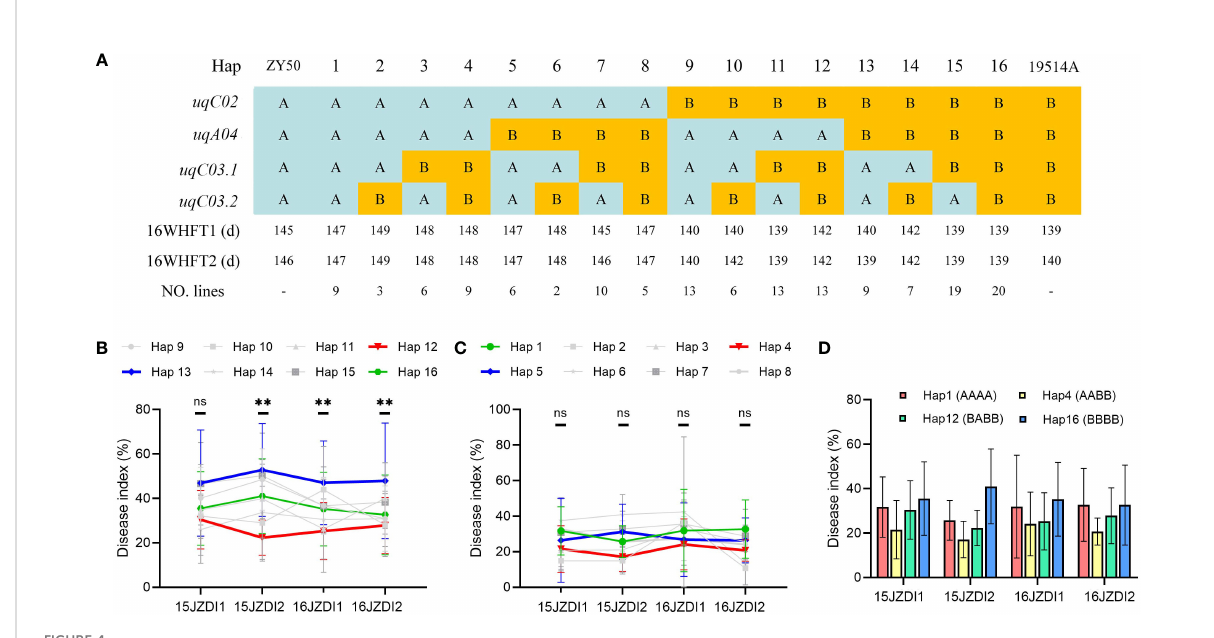
FIGURE 4 Haplotype analysis in the double haploid (DH) population. (A) DH population was divided into 16 haplotypes based on the genotypes of the four quantitative trait loci (QTLs). The number of lines per haplotype and average fl owering time (FT) are shown. (B) Mean value of disease index (DI) and order of haplotypes 9 – 16 in four replicates. Data are shown as the mean ± SD. Differences between haplotype 12 and haplotype 13 were analyzed for signi fi cance; ns indicates no signi fi cant difference, **P < 0.01 (one-way analysis of variance). (C) Mean value of DI and order of haplotypes 1 – 8 in four replicates, with the data shown as the mean ± SD. Differences between haplotype 4 and haplotype 5 were analyzed for signi fi cance; ns indicates no signi fi cant difference (one-way analysis of variance). (D) DI values of haplotype 4 were less than those of haplotype 1 in all four replicates; the DI values of haplotype 12 were less than those of haplotype 16 in all four replicates. Data are shown as the mean ±